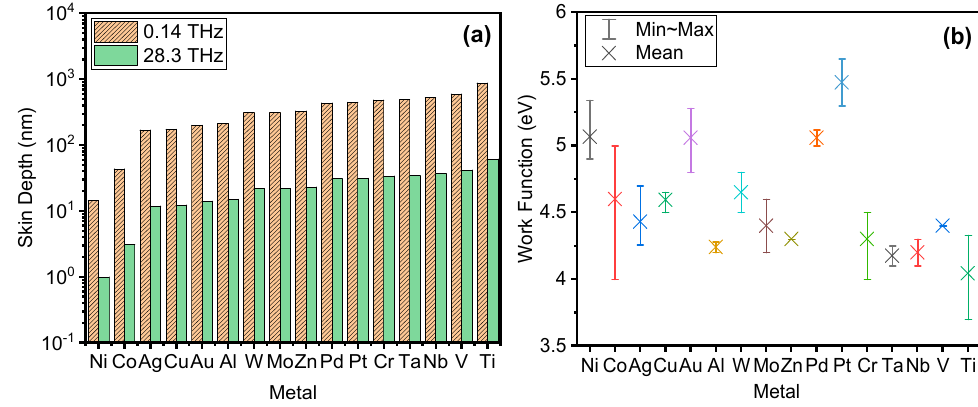
Figure 2. ( a ) Skin depth and ( b ) work function [11–20] for typical metals used in a rectenna. Figure 3a,b present electron affinities [9,17,32–44] and band gap [33,35,36,38,43,45– Table 1. Physical properties of metals and oxides: work function, electron affinity and band gap. 55] of typical oxides that have been used in the design and fabrication of MIM diodes. Full